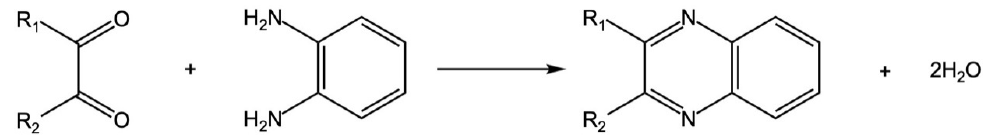
Figure 1. The reaction equation of OPD and α -DCs. Figure 9. Reverse aldol condensation of